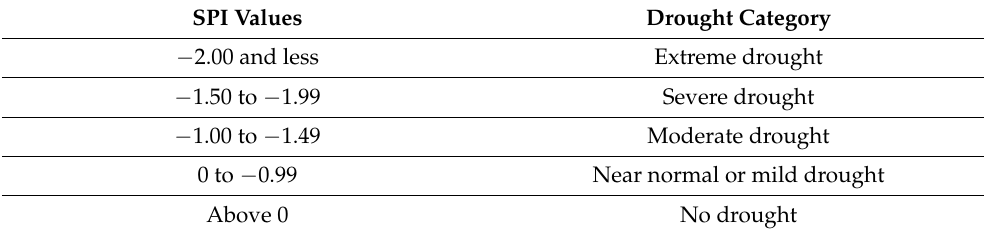
Table 3. Drought category based on McKee et al. [60].